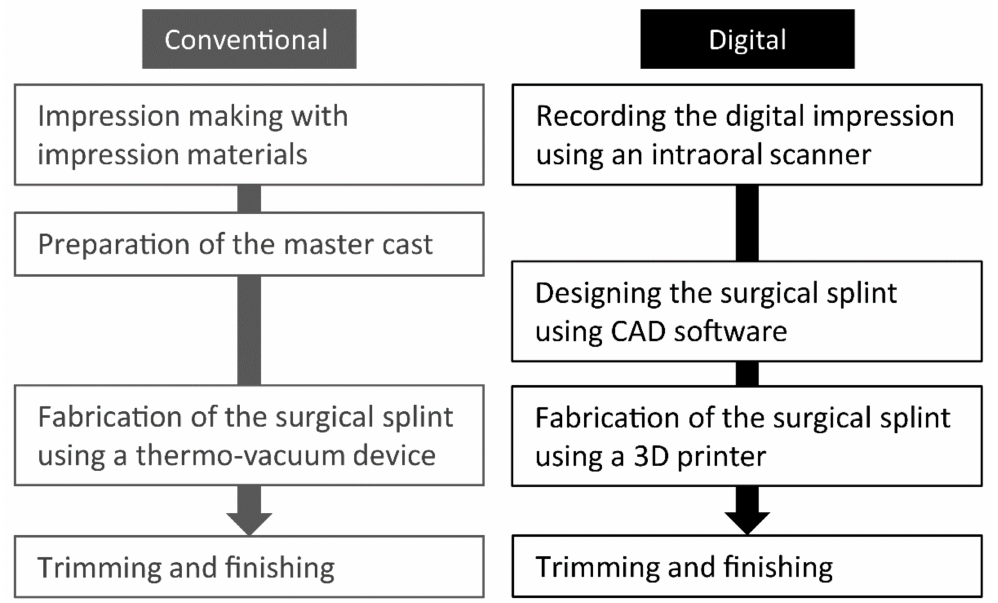
Figure 1. Summary of differences between the conventional and fully digital workflows for fabrication of surgical splints. CAD = computer-aided